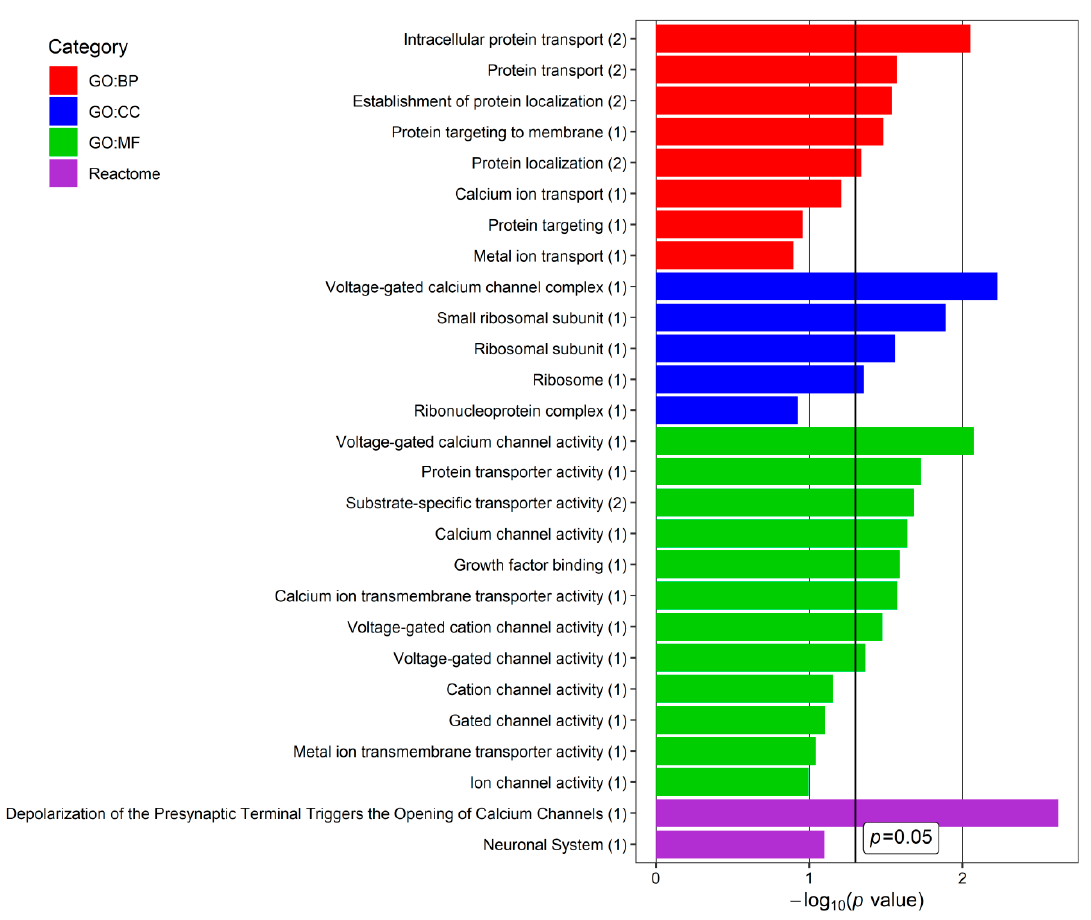
Figure 4. Terms of the Gene Ontology (GO): Biological Processing (GO:BP), GO: Cellular Compartment (GO:CC), GO: Molecular Function (GO:MF), and REACTOME categories, revealed for glaucoma- and/or pseudoexfoliation syndrome (PEX)-associated genes targeted by snoRNAs found in the current study in the aqueous humor (AH) of patients with PEXG and age-matched controls. p -value—EASE score for enrichment adjusted by the Benjamini correction for multiple-hypothesis testing. The number in brackets following the names of terms indicates the number of associated genes. The plot was generated using the ggplot2 3.3.0 package in R.